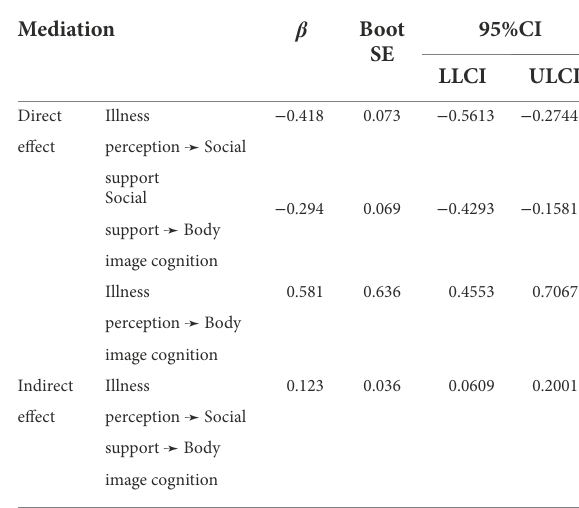
TABLE 5 Results of mediation effect.